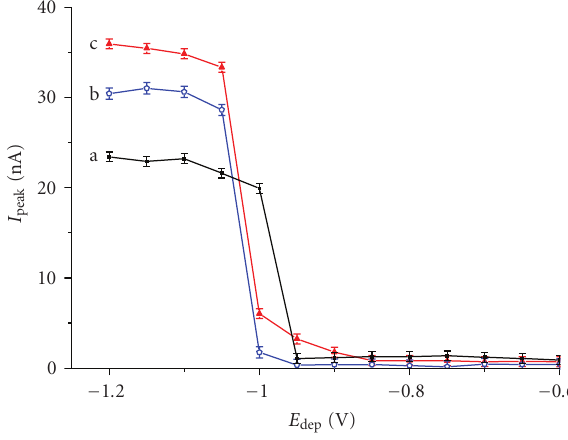
Figure 3: Standard addition for copper in (a) Original Sample , (b) SoUV Sample, and (c) UV Sample.